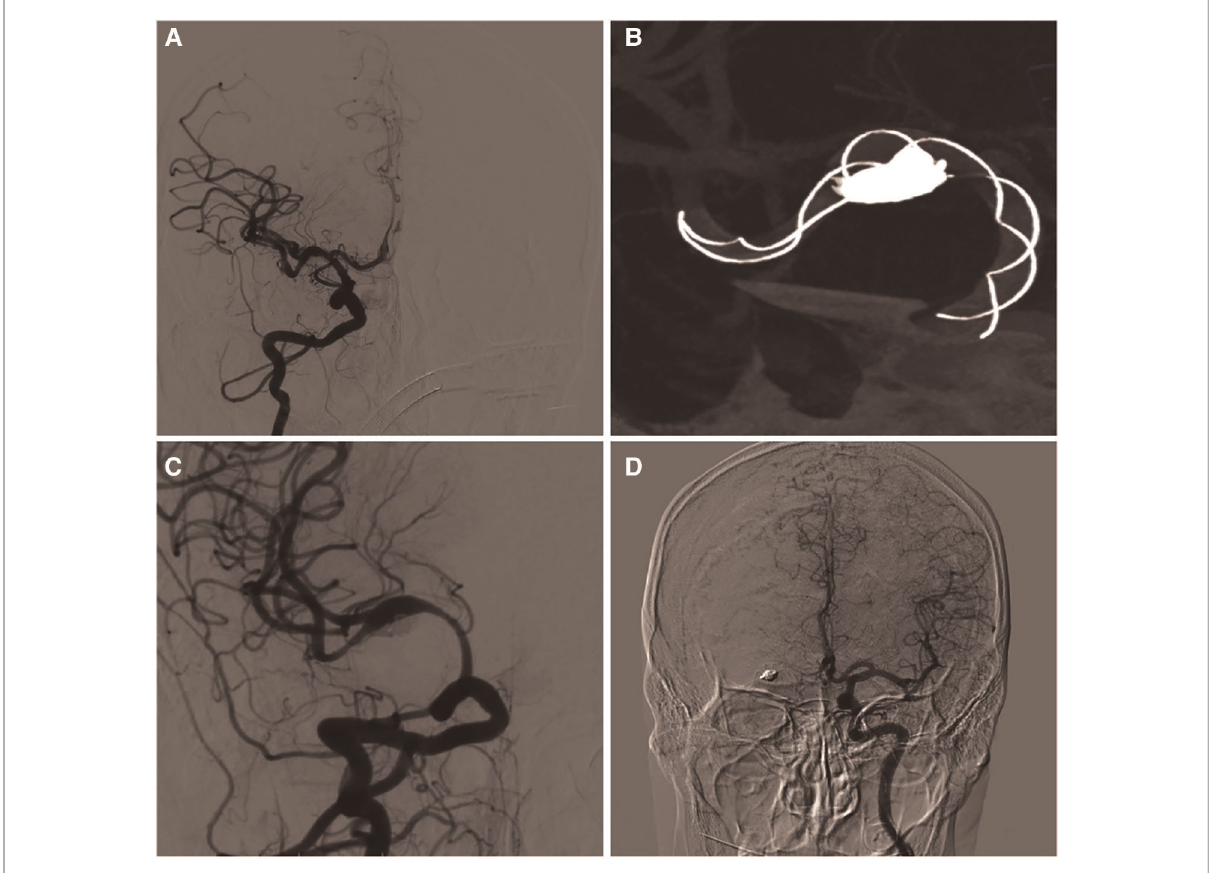
FIGURE 2 ( A ) patient was treated by embolization with TFD. ( B ) The stent is completely released and fi lled with coils through microcatheter. ( C ) two months later, angiographic follow-up showed partial occlusion of the aneurysm and moderate in-stent stenosis of the ipsilateral middle cerebral artery. ( D ) The anterior communicating artery was open and the ipsilateral anterior cerebral artery was well